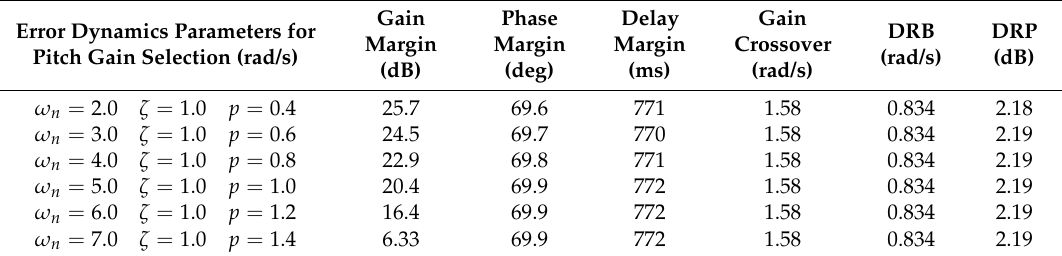
Table 5. Variation in roll axis stability margins and disturbance rejection performance with variation in pitch axis gain